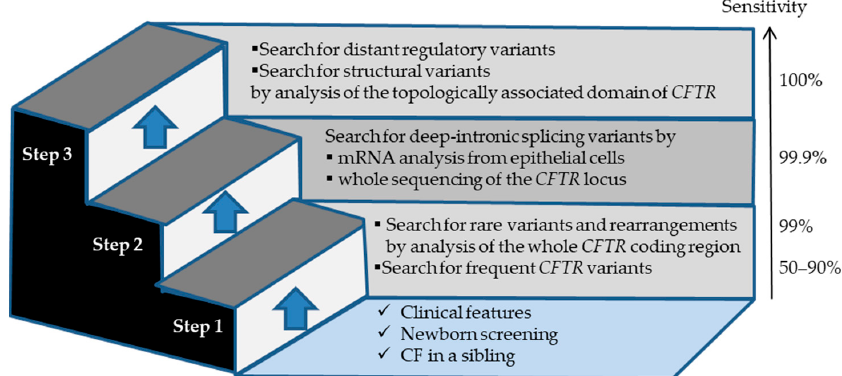
Figure 1. Molecular investigation for the diagnosis of cystic fibrosis (CF) and cystic fibrosis transmembrane conductance regulator related disorders (CFTR-RD) in three steps. Sensitivity refers to variant detection rate in patients with CF.